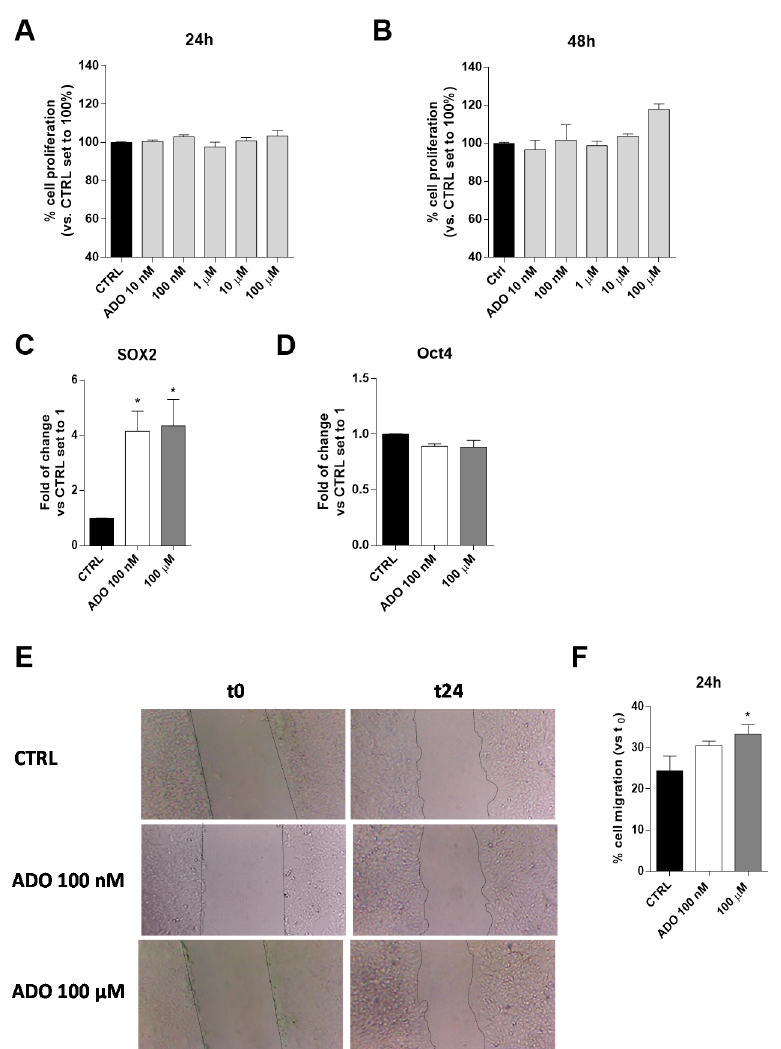
Figure 1. Effects of ADO on U343MG cell proliferation, expression of stemness genes and cell motility. ( A , B ) U343MG cells were treated with different concentrations of ADO (10 nM to 100 µM) for: 24 h ( A ); or 48 h ( B ). At the end of the treatment, cell proliferation was evaluated, as described in Section 4.3. The data are expressed as percentages relative to untreated cells (CTRL), which were set at 100% (mean ± SEM; N = 3). ( C , D ) The total RNA was extracted from U343MG cells after treatment with ADO (100 nM and 100 µM) for 48 h, and the relative mRNA quantification of the markers SOX2 ( C ) and Oct4 ( D ) was performed by RT-PCR, as described in Section 4.4. The data are expressed as fold changes with respect to basal value set to 1 (mean values ± SEM, N = 2). ( E , F ) U343MG cells were treated with ADO (100 nM or 100 µ M) and the healing of the wound was evaluated in the scratch assay. ( E ) Representative images of the scratch wounds at 0 and 24 h. ( F ) The data are expressed as percentage of gap closure after 24 h of treatment compared to the untreated cells (CTRL), set to 100%. The data are represented as the means ± SEM of at least of three independent experiments. The significance of di ff erences was determined by one-way ANOVA, followed by Bonferroni’s post hoc test: * p < 0.05 vs.